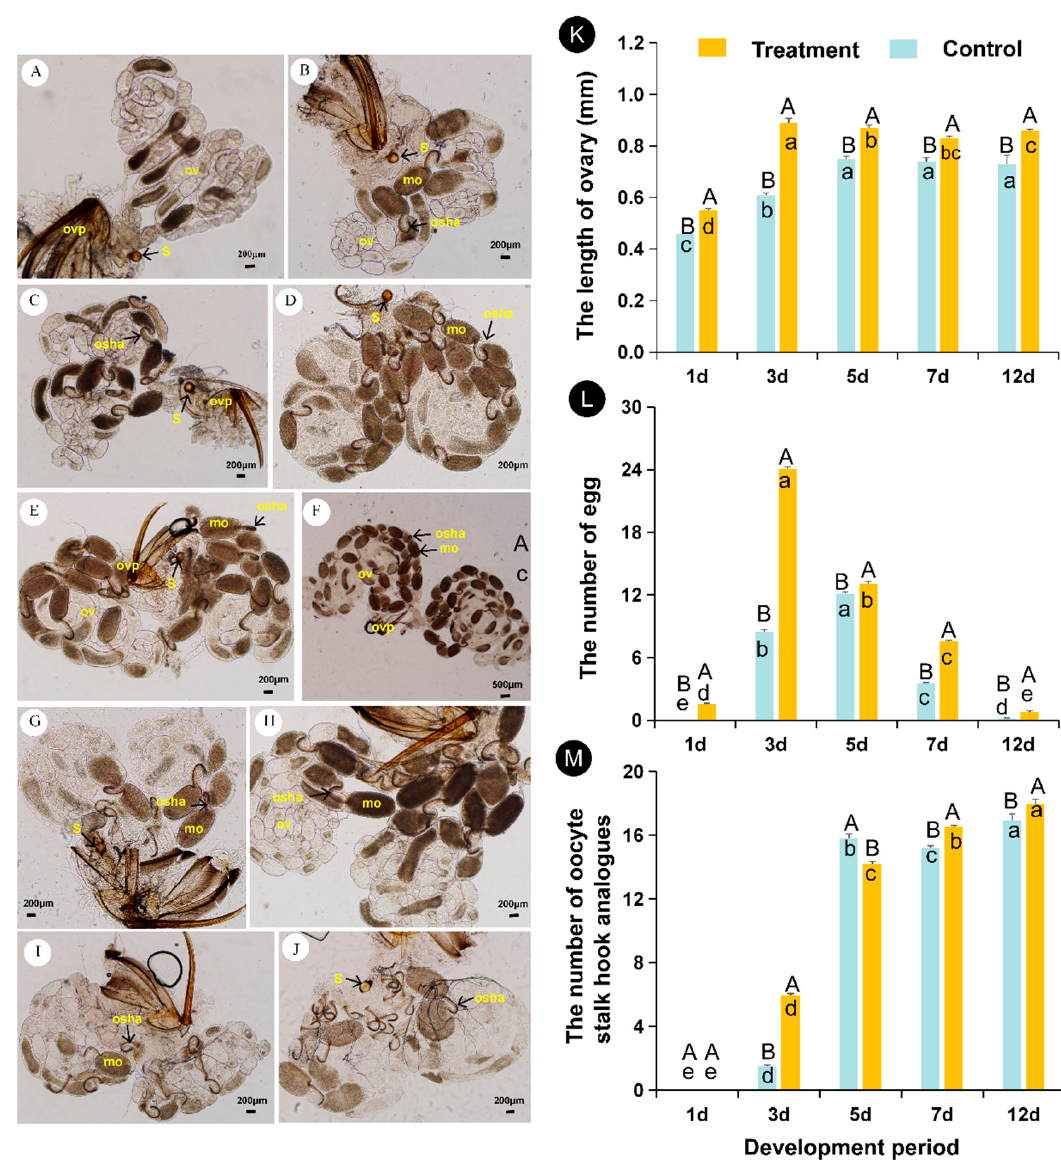
Figure 2. Morphology and developmental dynamics of Aenasius bambawalei ovaries at different temperatures. ( A , C , E , G , I ) represent the morphology of ovaries from control females at the early stage i (1 day after emergence), early stage ii (3 days after emergence), middle stage (5 days after emergence), final stage i (7 days after emergence), and final stage ii (12 days after emergence), respectively; ( B , D , F , H , J ) represent the morphology of ovaries from heat-treated females at the early stage i (1 day after emergence), early stage ii (3 days after emergence), middle stage (5 days after emergence), final stage i (7 days after emergence), and final stage ii (12 days after emergence), respectively. In ( K , L , M ), the different uppercase letters indicate that there is a significant difference between the high temperature treatment and the control, while the different lowercase letters indicate that there is a significant difference at different developmental periods. Ovp—ovipositor, ov—ovary, s—spermatheca, mo—mature oocytes, osha—oocyte stalk hook analogs. Bars in-( A – J ) (except ( F )) indicate 200 µ